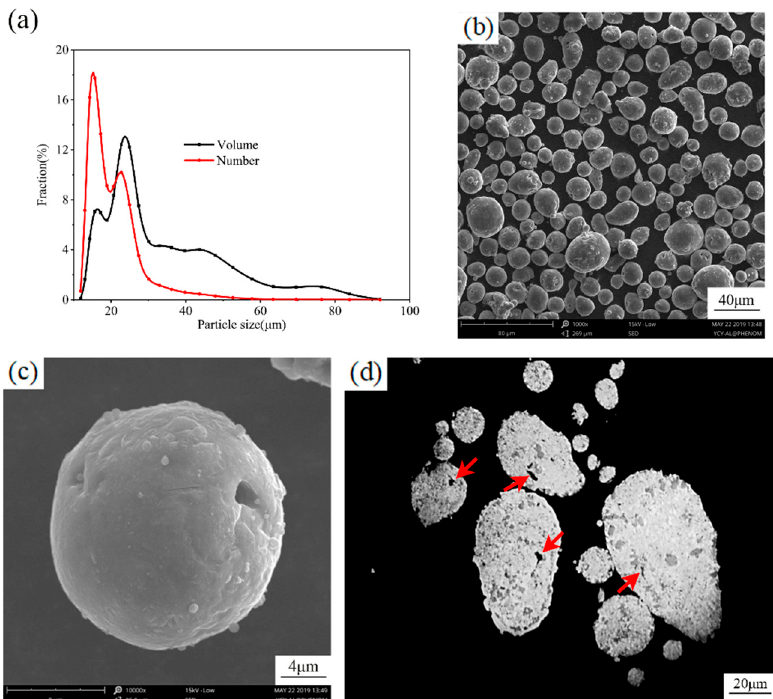
Figure 2. ( a ) Particle size distribution and ( b , c ) morphologies of fresh feedstock powder and ( d ) its cross-section image with red arrows referring to irregular internal pores.